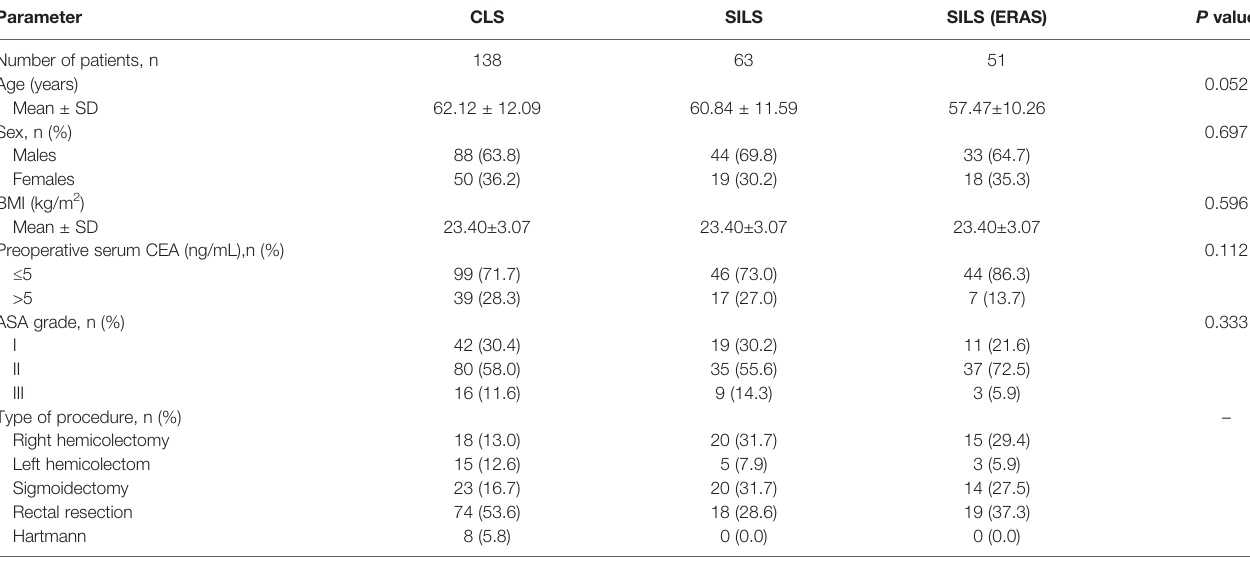
TABLE 2 | Patient demographics, baseline characteristics, and type of operations performed according to tumor location.